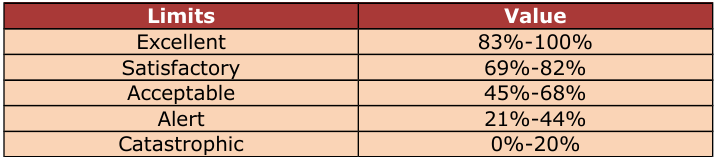
Table 5. Limit values between states in green manufacturing criterion